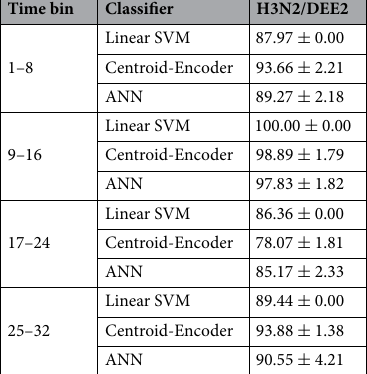
Table 5. Balanced success rate (BSR) of LOSO testing applied on the study H3N2/DEE2 using the features from the other 6 data sets, i.e., Feature Set 2. Limma is applied on Study